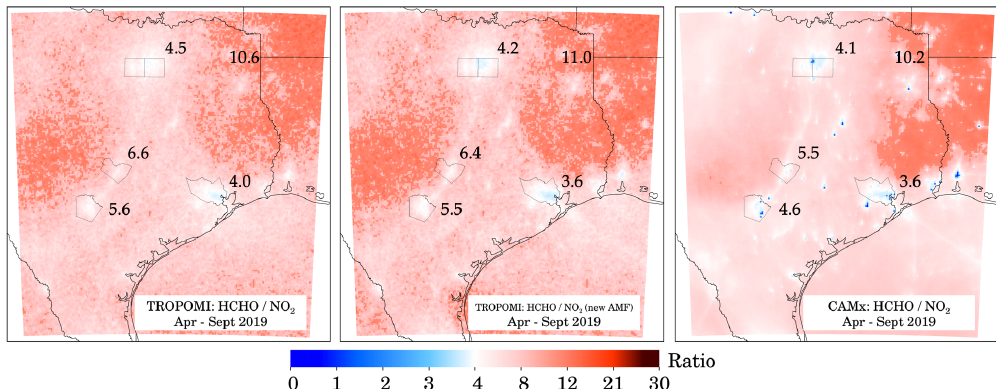
Figure 11. The formaldehyde / NO 2 ratio (FNR) in Texas averaged across April through September 2019, using the (left panel) operational TROPOMI products, (center panel) operational TROPOMI HCHO product and TROPOMI NO 2 product with new AMFs, and (right panel) CAMx column amounts. Only CAMx data coincident with the overpass time and valid TROPOMI pixels are included. The ratios from the satellite and model for each area are shown directly in the plot.